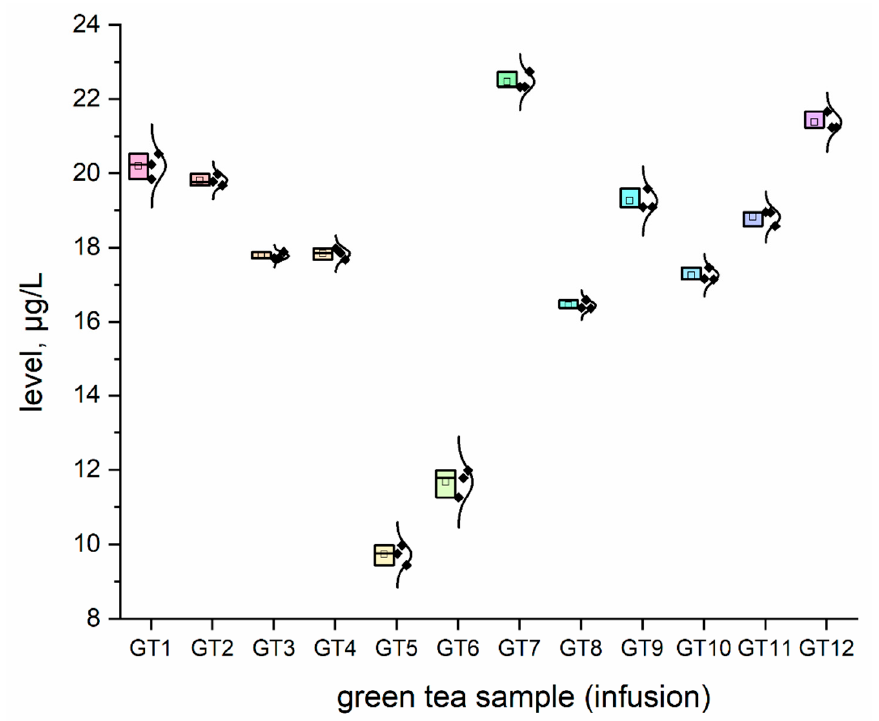
Figure 7. The plot as a box chart, with a normal distribution curve for Sr concentration ( µ g/L) in analysed green tea samples (infusions; GT1–GT12). The colors indicate the results for the individual tested samples, the symbol indicates the standard deviation.